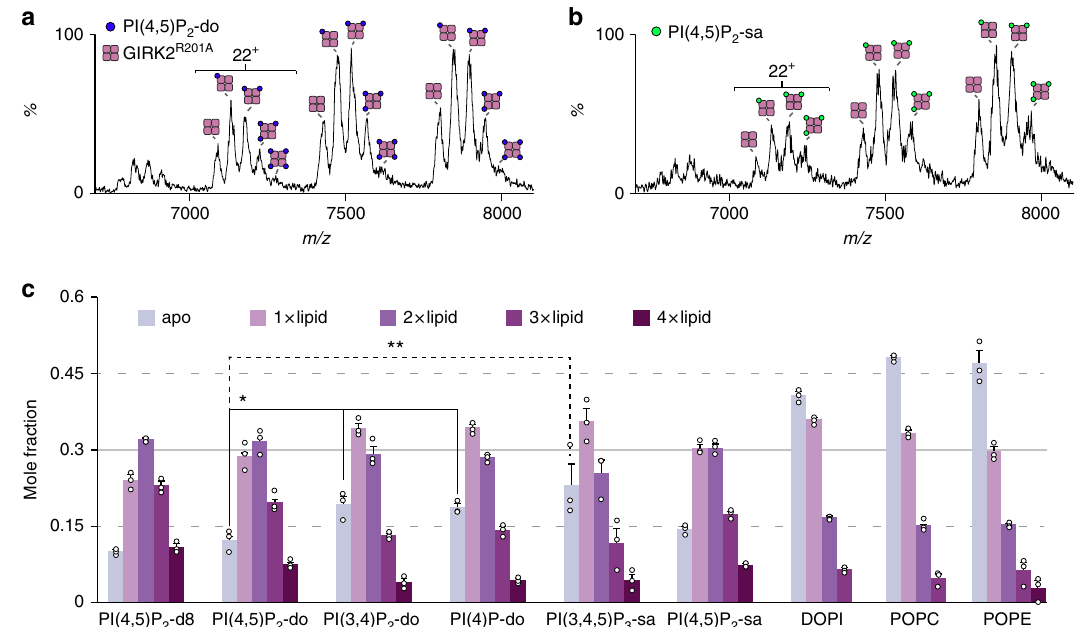
Fig. 4 Altered selectivity of GIRK R201A toward PIPs and phospholipids Representative mass spectra of GIRK2 R201A mixed with six equivalents of a PI(4,5) P 2 -do and b PI(4,5)P 2 -sa. c Mole fraction derived from mass spectrometry data for GIRK2 mixed with different lipids at sixfold molar excess. Reported is the average and s.e.m. ( n = 3). Student ’ s t test (two-tailed) was used for statistical analysis ( * P < 0.03) as described in Fig. 3. Source data are provided as